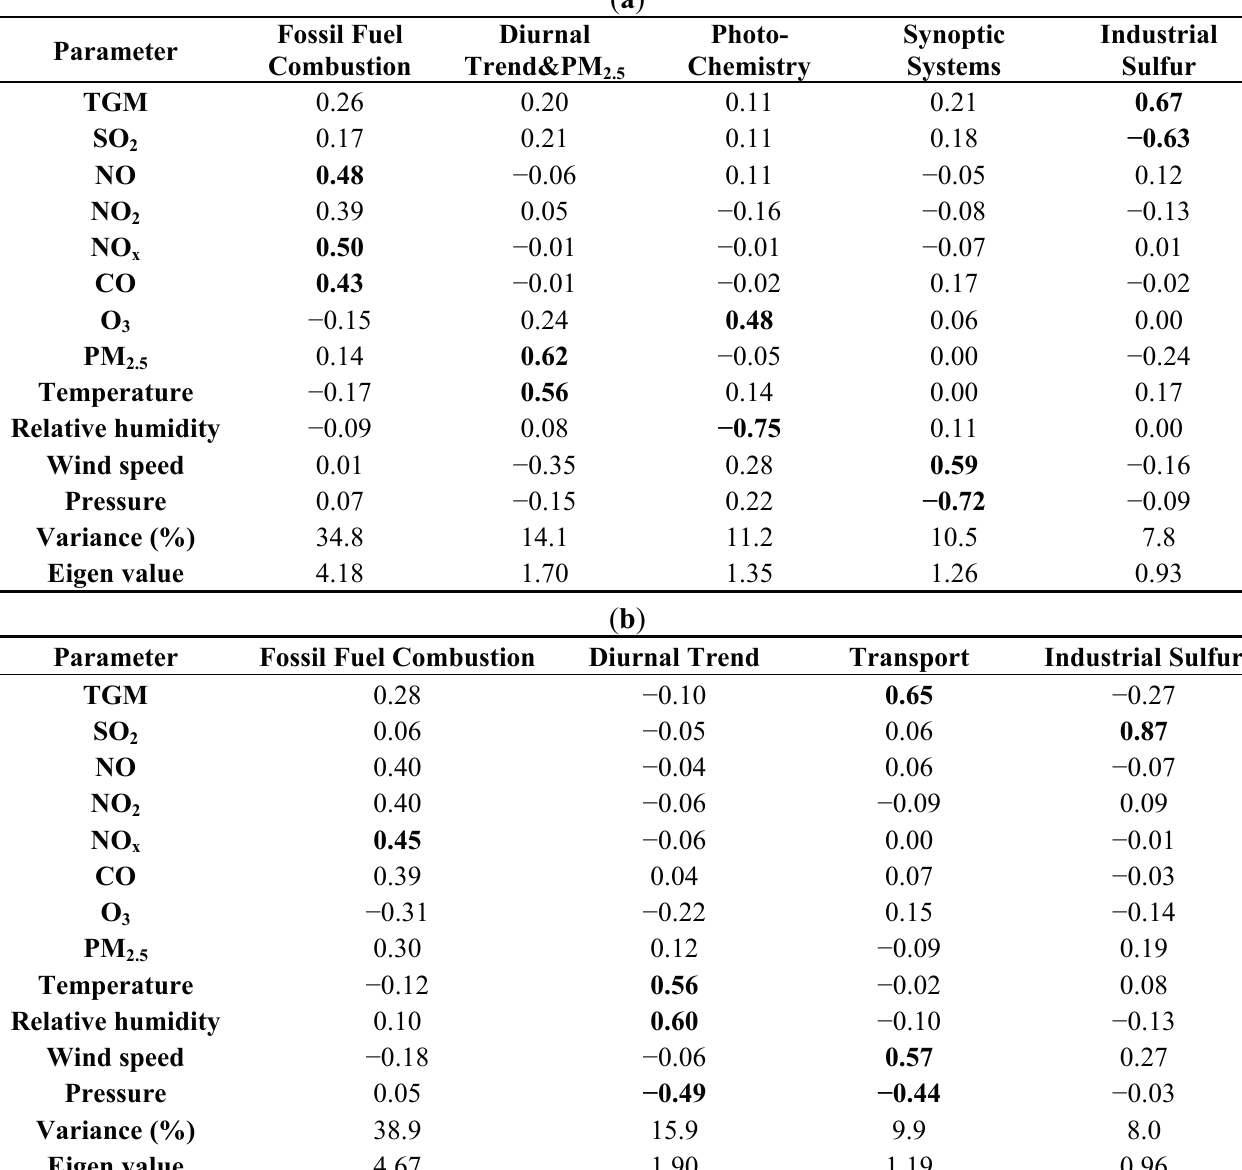
Table 3. Principal component analysis (PCA) factor loadings (bold numbers